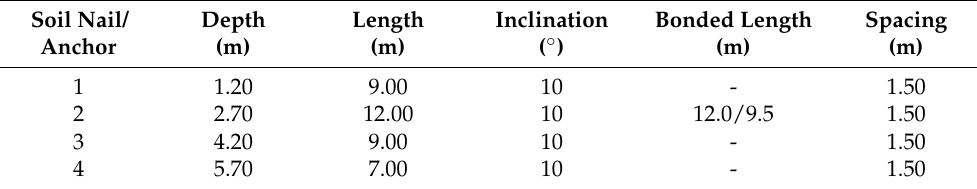
Table 4. Design parameters of composite soil-nailed retaining structures. Soil